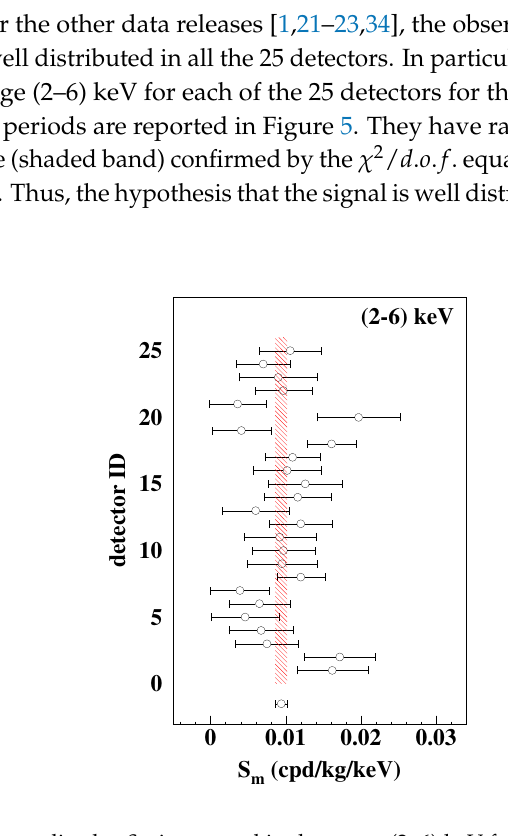
Figure 5. Modulation amplitudes S m integrated in the range (2–6) keV for each of the 25 detectors for the DAMA/LIBRA–phase1 and DAMA/LIBRA–phase2 periods. The errors are at 1 σ confidence level. The weighted averaged point and 1 σ band (shaded area) are also reported. The χ 2 is 23.9 over 24 d . o . f ., supporting the hypothesis that the signal is well distributed over all the 25